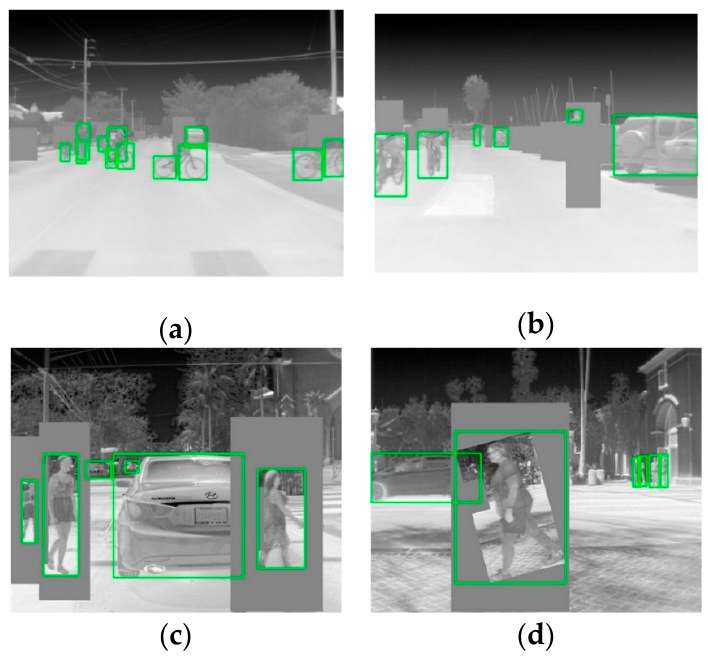
Figure 3. Examples of the results of instance level data augmentation before rotation. Green lines indicate annotations after transformation. ( a ) and ( b ) are augmentation examples for bicycles, ( c ) and ( d ) are augmentation examples for persons.